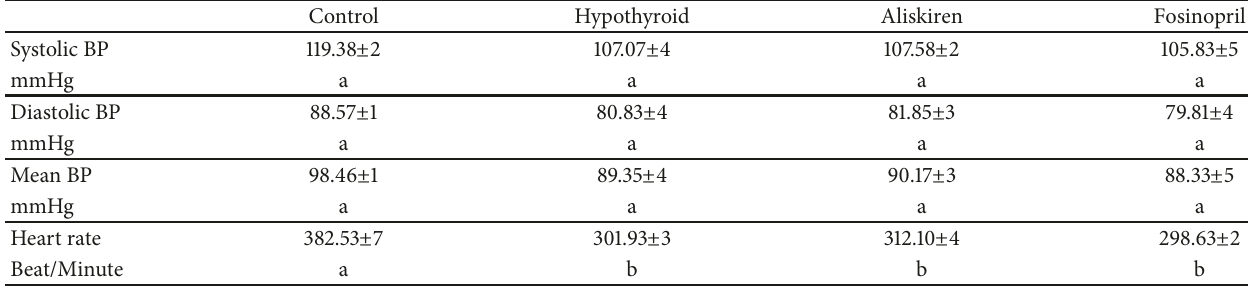
Table 5: The relation between blood pressure (BP) and heart rate in control, hypothyroid, Aliskiren, and Fosinopril groups.